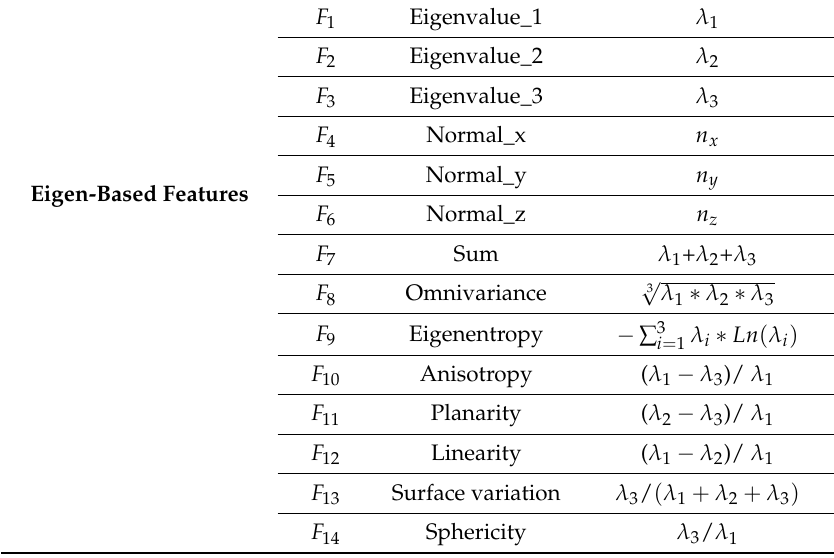
Table 1. The feature set based on point cloud